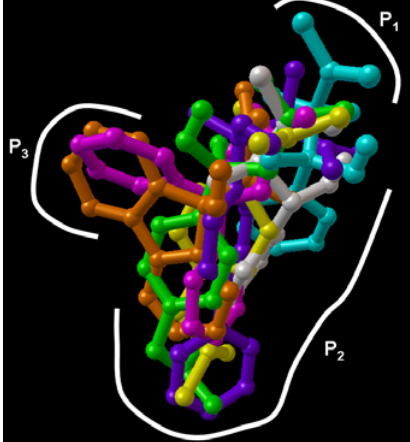
Figure 5 . Anchor sites of COX/2 receptors and best docking poses of compounds 1 (green), 2 (blue), 3 (pink), 4 (gray), 5 (orange), 6 (purple) and ibuprofen (yellow). This picture was made using AutoDockTools